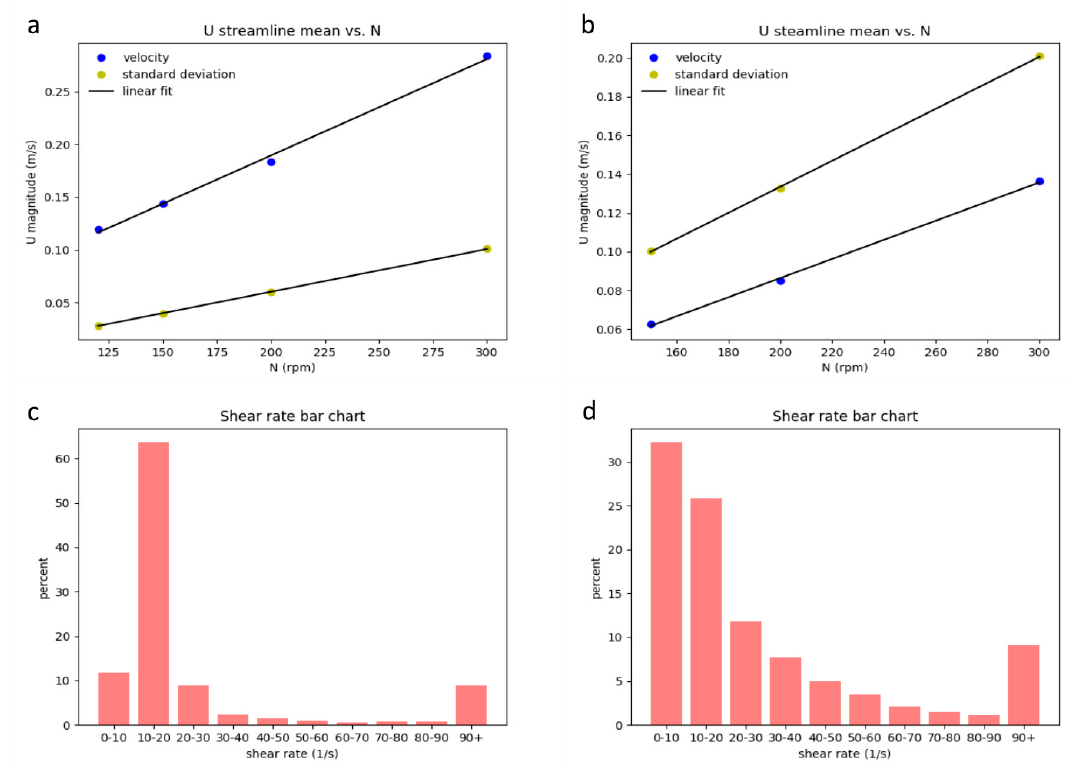
Figure 7. Experiments E ( a , c , unba ffl ed) and B ( b , d , ba ffl ed) results for velocity profile and standard deviation ( a , b ) and for shear rate ( c , d